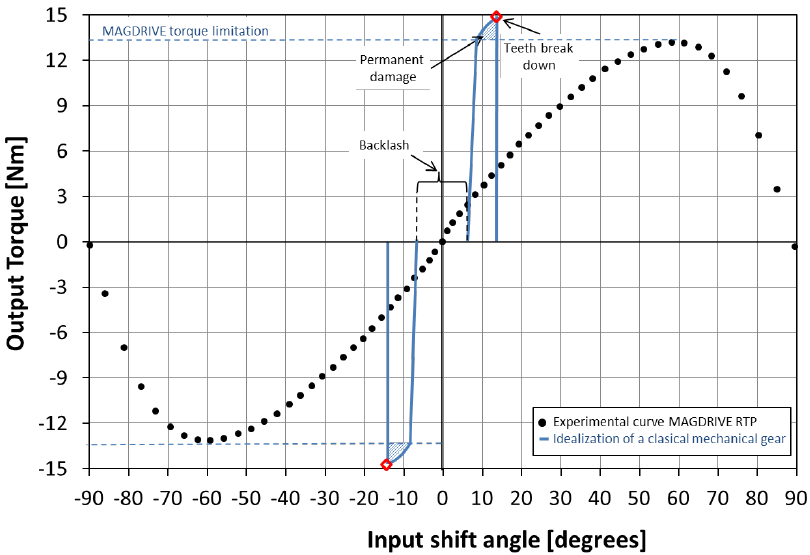
Figure 3. Experimental Torque vs. angle shift in MAGDRIVE Prototype (black dots) compared to a perfect mechanical gear (blue